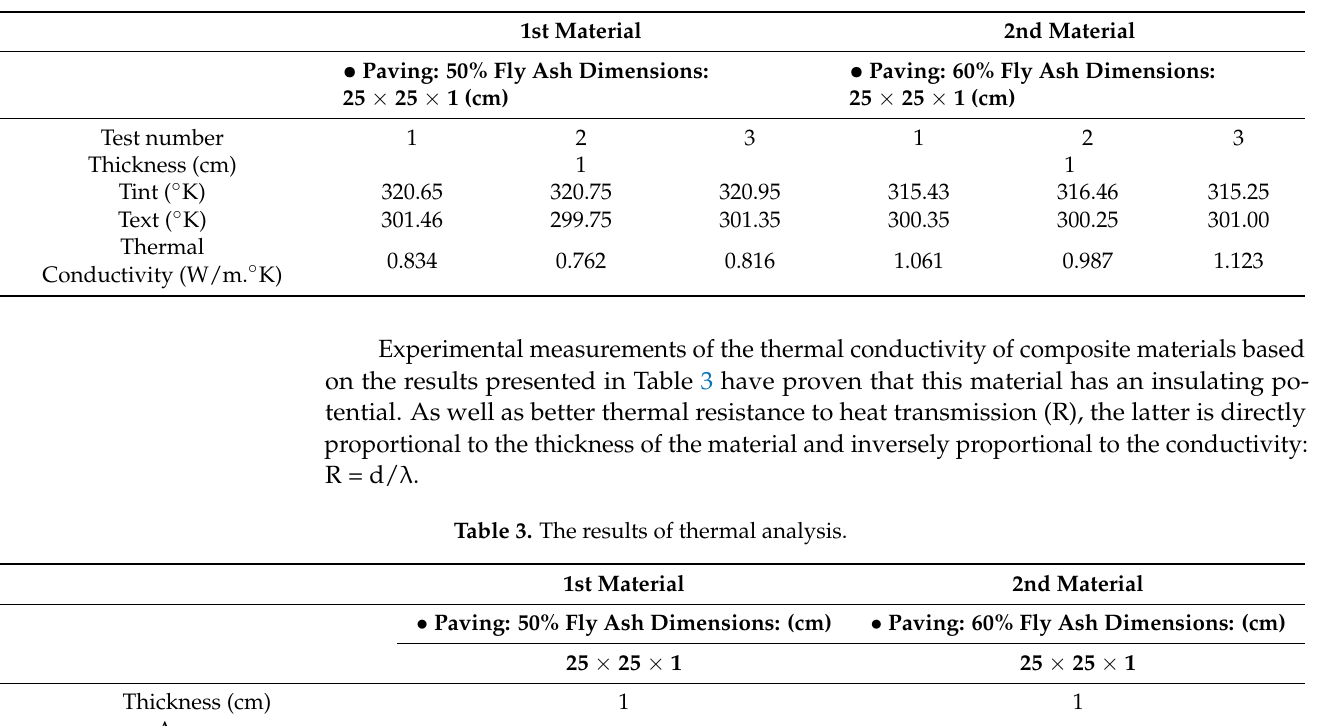
Table 2. The results of thermal analysis.